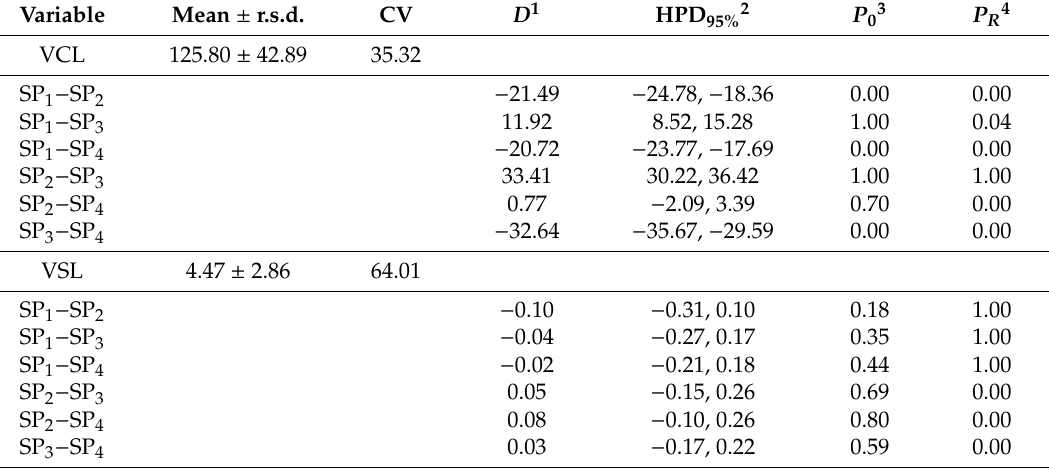
Table 6. Kinematic bull sperm variables and estimated marginal posterior distribution of di ff erences between motile sperm SPs.